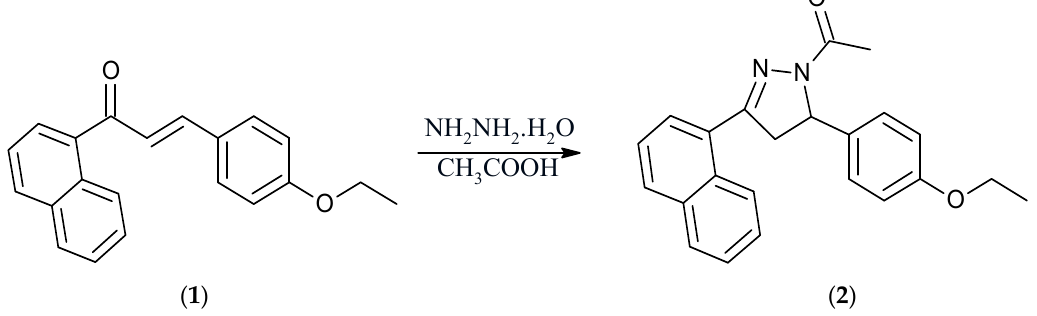
Figure 1. ( a ) 2D and ( b ) 3D docking pose of the standard drug fluconazole with MTCYP51.